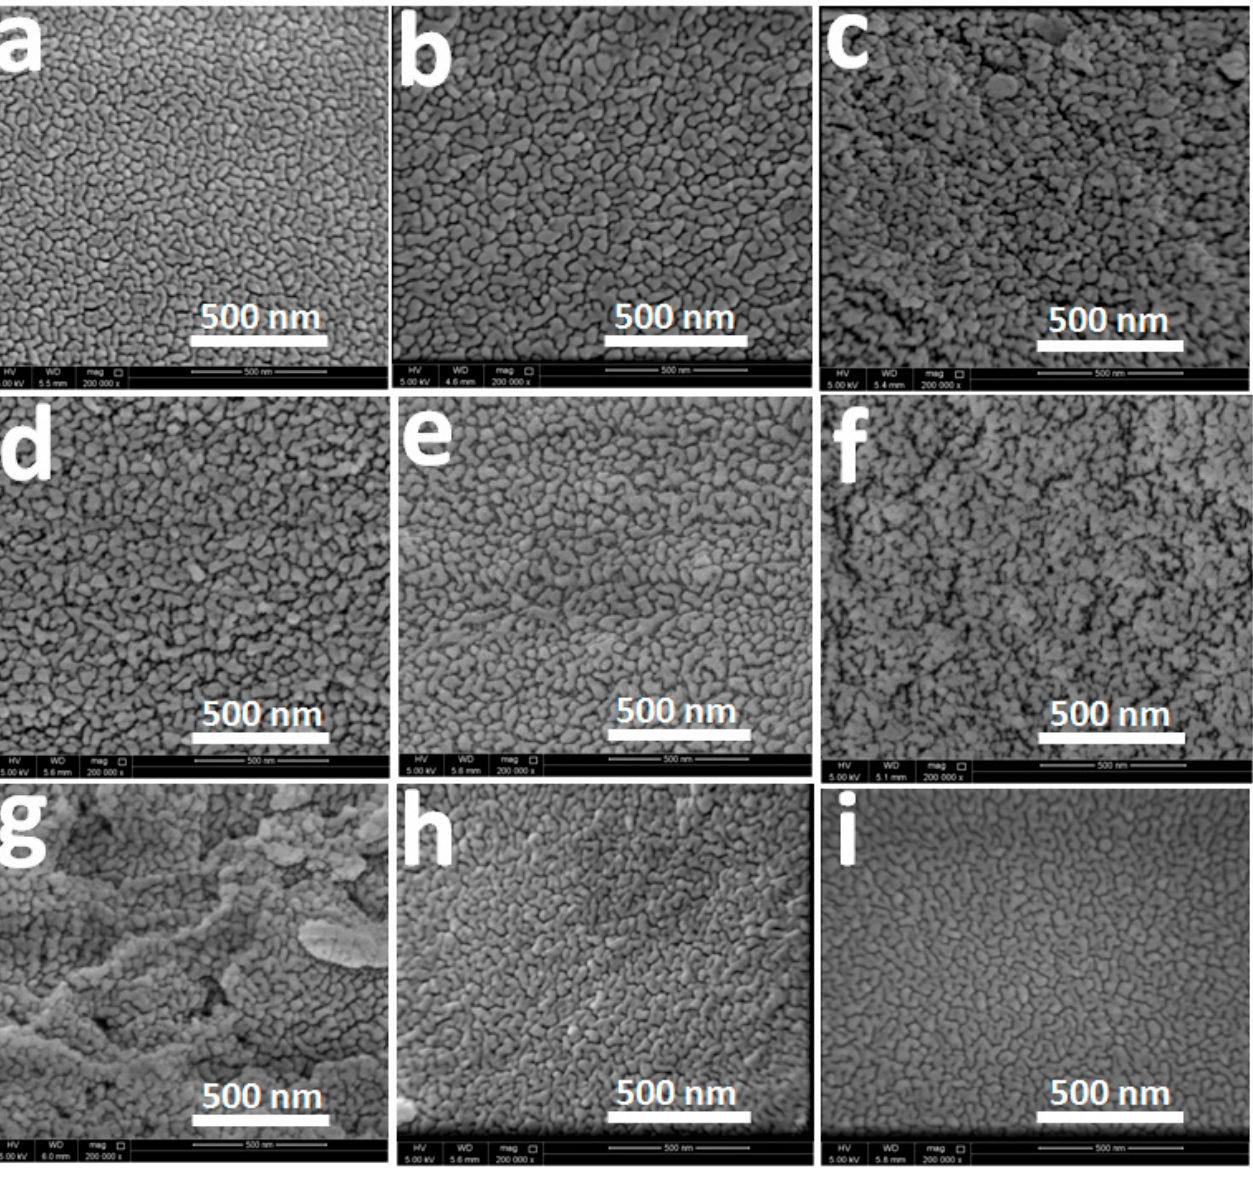
Figure 11. NanoSEM photo micrographs of ( a ) RFG1, ( b ) RFG2, ( c ) RFG3, ( d ) RFG4, ( e ) RFG5, ( f ) RFG6, ( g ) RFG7, ( h ) RFG8 and ( i ) RFG9 samples.